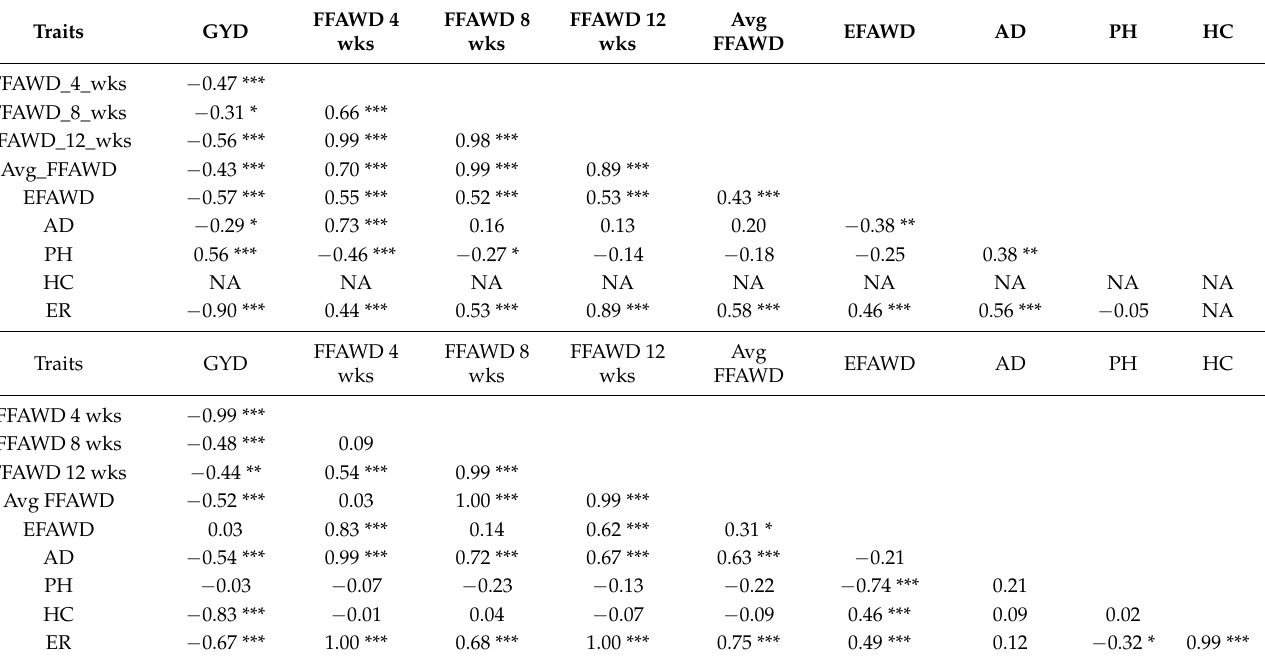
Table 8. Genetic correlations between grain yield and yield related traits with fall armyworm damage scores at different crop growth stages determined under natural fall armyworm infestation in Zimbabwe during 2019–2020 seasons.